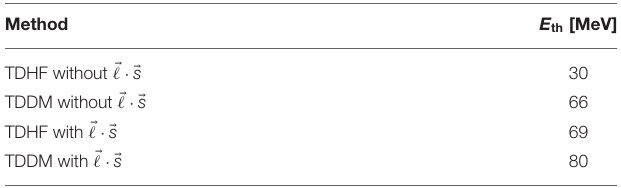
TABLE 3 | Threshold energy E th in the center-of-mass frame for the head-on collisions of 16 O + 16 O.